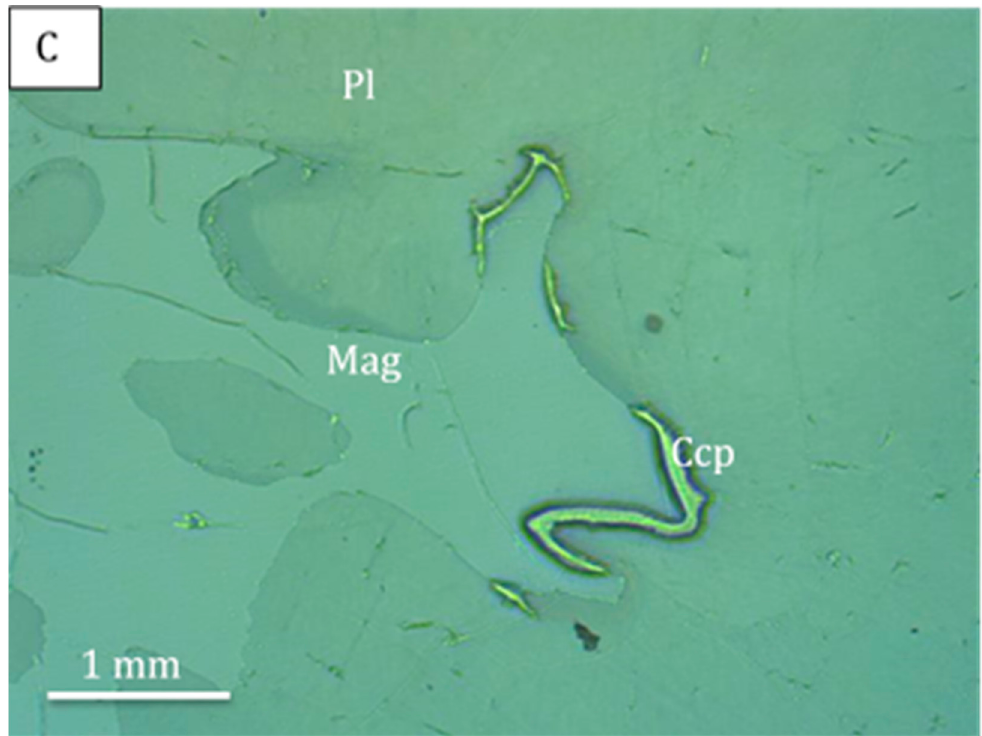
Figure 4. Magnetite ‐ bearing olivine gabbro showing: ( A ) Cumulus texture in plagioclase and olivine with biotite (Bt) ‐ magnetite (Mag) intergrowth in small interstitial spaces (transmitted light); ( B ) Biotite ‐ magnetite intergrowth and fine disseminated chalcopyrite (reflected light); ( C ) Thin rim of chalcopyrite (Ccp) around titaniferous magnetite (Mag) in contact with plagioclase (Pl).